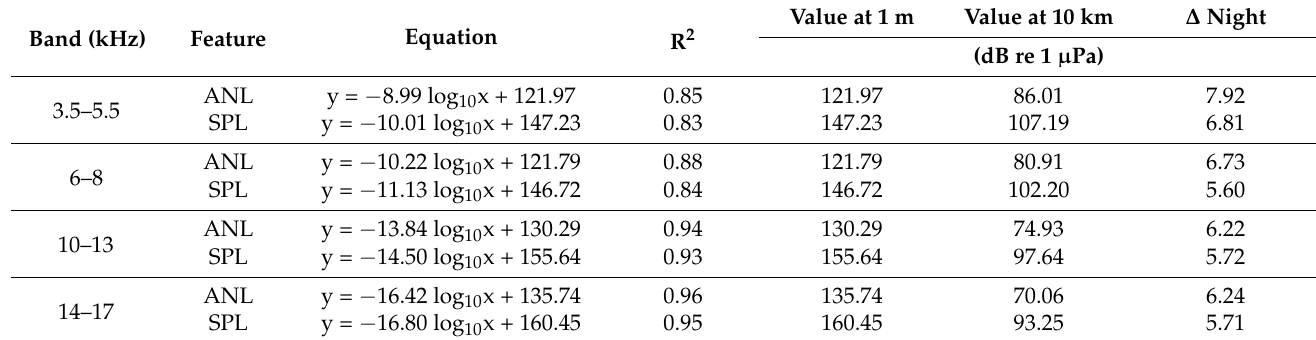
Figure 5. ( A ) In situ measurements of the sound pressure level (SPL) and ambient noise level (ANL) for the band 3.5–5.5 kHz for each of the six transects up to 10 km. ( B ) Logarithmic regression with a modelled propagation loss (= transmission loss, (cid:16) (cid:17) + α ( r − r = 0.274 dB km − 1 for distances beyond 10 km. In red, Wenz ) with r r · r − 1 TL): TL = 10log 0 0 = 10 km and α 0 background noise for wind speeds between 0 and 18 kn (from bottom to top: 0, 3, 6, 9, 12, 15 and 18 kn). Table 1. Regressions of benthic transient sounds (BTS) levels (dB re 1 µ Pa) at 1 m and 10 km from the reef crest for the ambient noise level (ANL) and the sound pressure level (SPL). Equations correspond to propagation loss regression equations assessed form the empirical